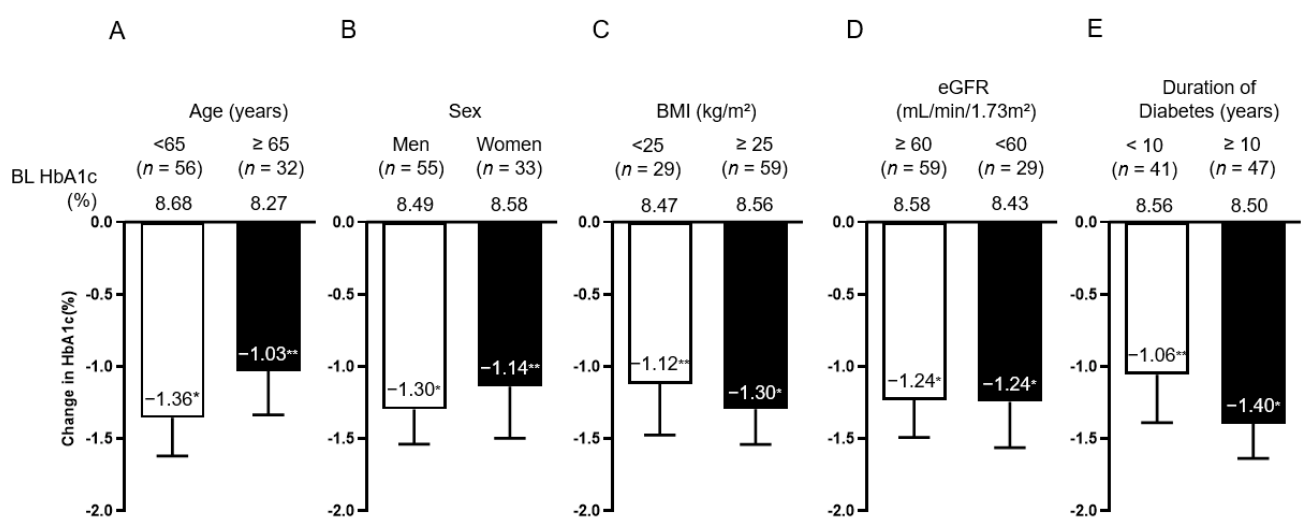
Figure 3. Change in HbA1c by subgroup; age ( A ), sex ( B ), BMI ( C ), eGFR ( D ), and diabetes duration duration ( E ). Data in the figure are presented as mean with SEM. * p < 0.001; ** p < 0.01 in the ( E ). Data in the fi gure are presented as mean with SEM. * p < 0.001; ** p < 0.01 in the Wilcoxon signed- Wilcoxon signed-rank sum test (vs. BL HbA1c). BL, baseline; HbA1c, glycated hemoglobin; BMI, rank sum test (vs. BL HbA1c). BL, baseline; HbA1c, glycated hemoglobin; BMI, body mass index; eGFR, estimated glomerular fi ltration rate; SEM, standard error of the mean. body mass index; eGFR, estimated glomerular filtration rate; SEM, standard error of the